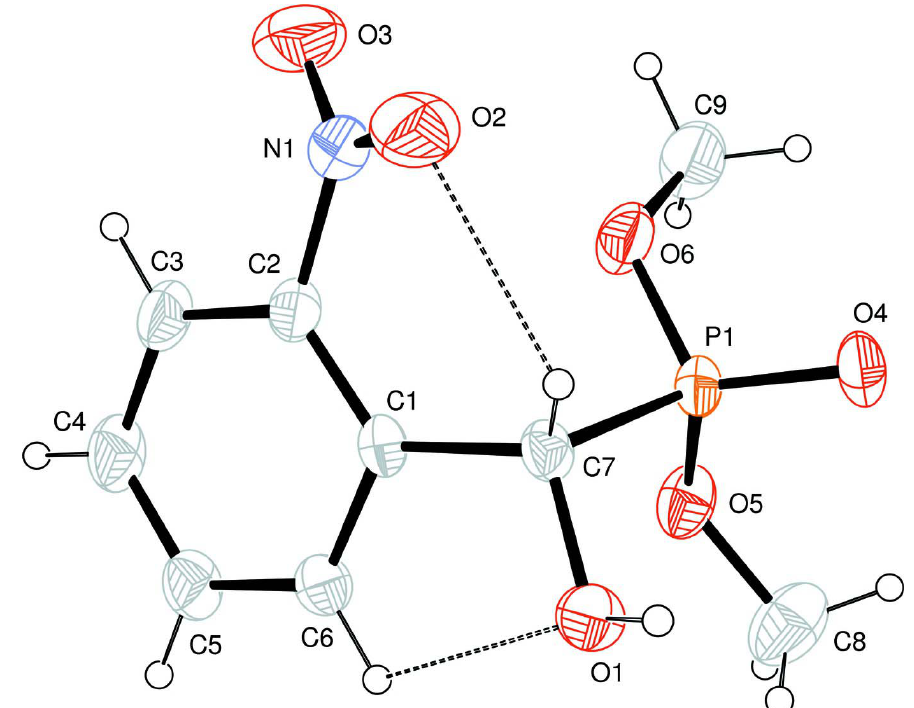
H NO P), with the atom numbering scheme. The thermal ellpsoids are drawn 9 12 6